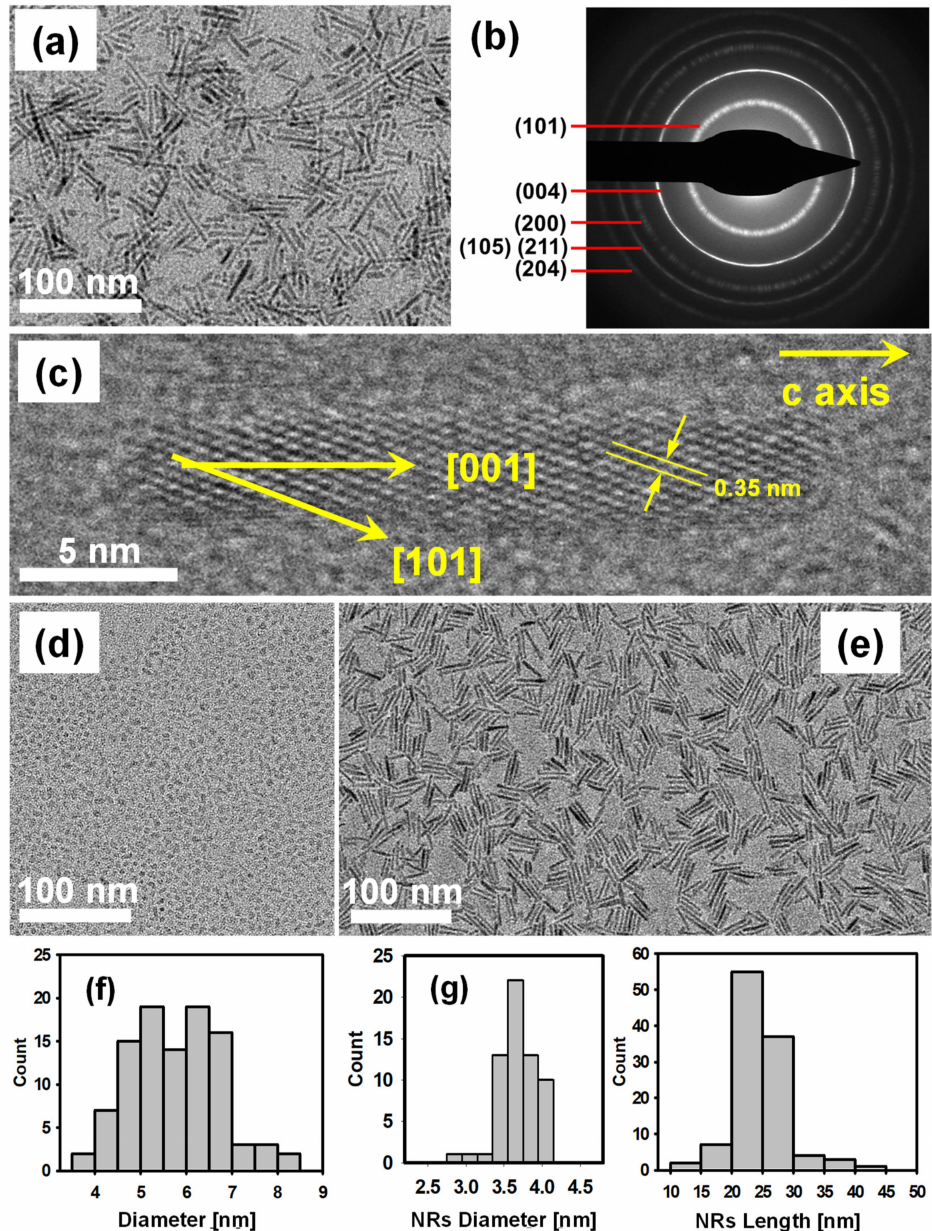
Figure 1. ( a ) As-synthesized TiO 2 NCs including NRs of different aspect ratios and semispherical NCs; ( b ) SAED pattern of anatase NRs presenting reflected rings clearly indexed to typical planes of anatase; ( c ) an individual anatase NR that has a (010) zone axis growing along the (001) direction. ( d – g ) TiO 2 NCs after the size-selective process in two main categories, NRs and semispherical NCs, and their corresponding size distributions from a statistical analysis of TEM